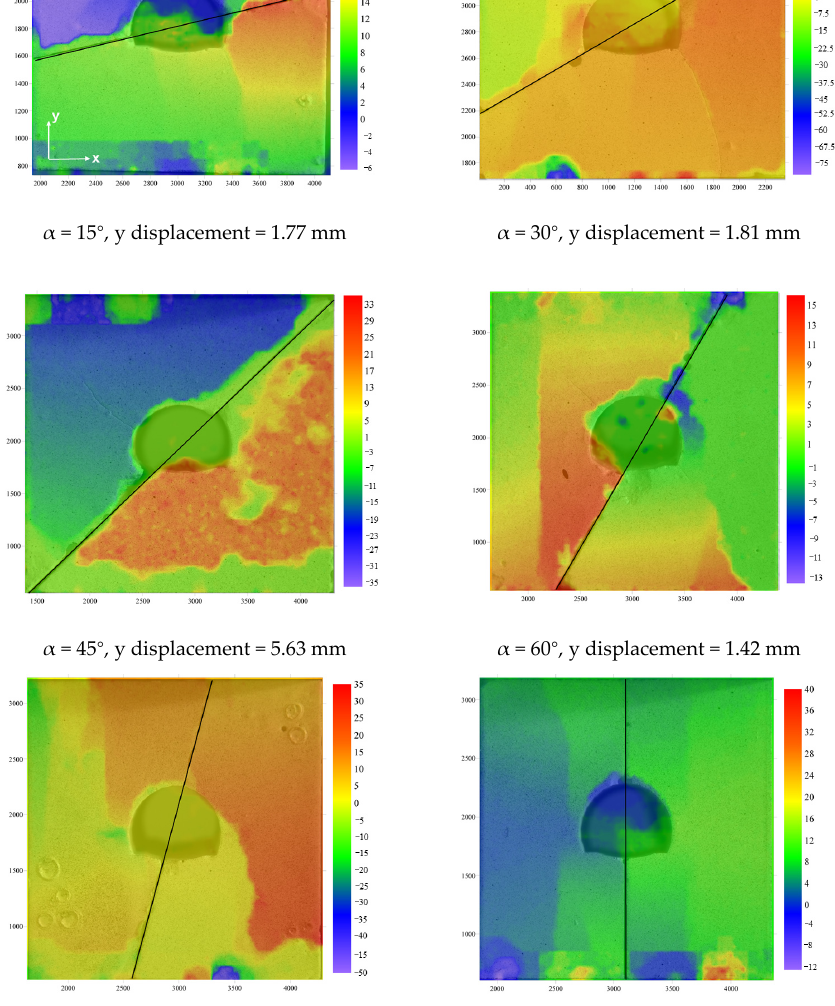
Figure 6. Displacement contour of x direction (unit: 0.01 mm). The black dash line is discontinuous plane. The results were calculated when the sample reached peak strength. The x and y label are the number of pixel points, which is useless for calculation.